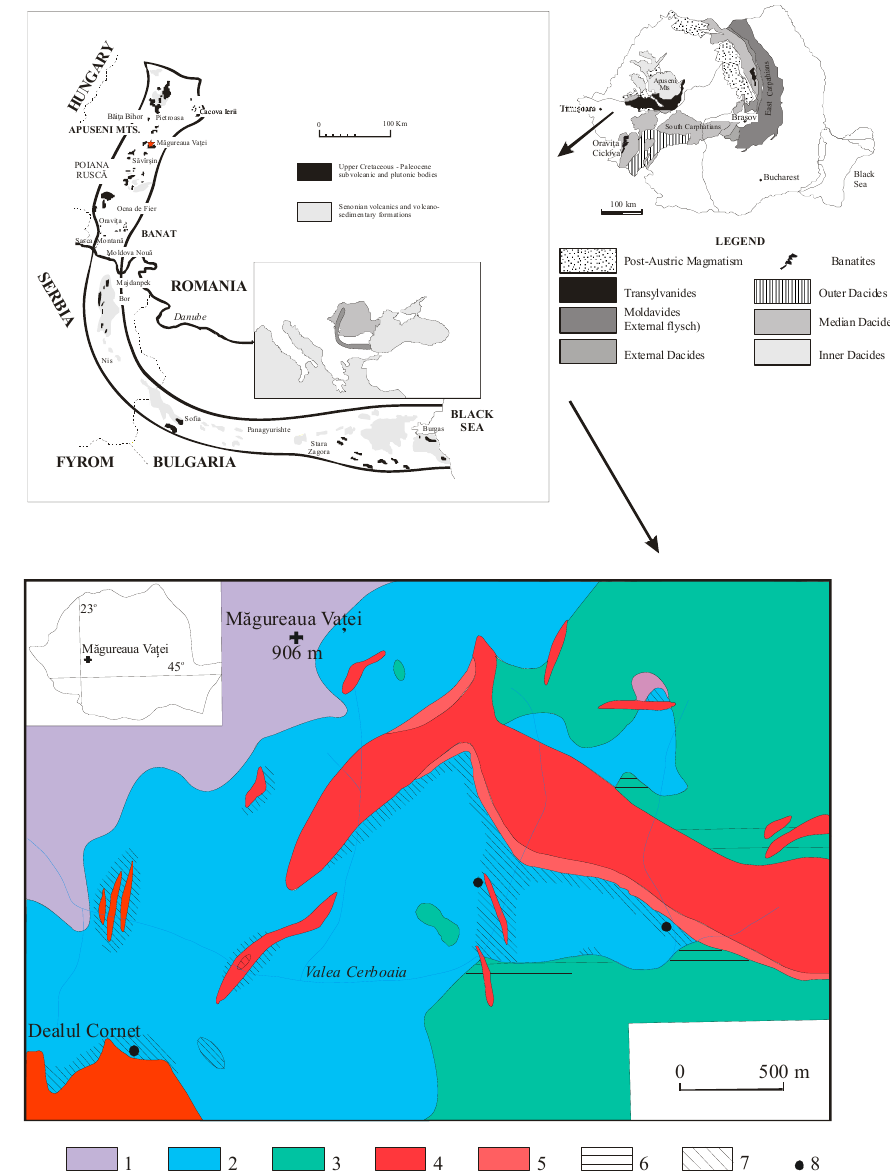
Figure 1. Geological sketch of M ă gureaua Va ţ ei zone (redrawn and modified from [5]) in the regional context: the Banatitic Magmatic and Metallogenetic Belt (top, left: redrawn from [18]) and the structural context of Romania (top, right: redrawn and simplified from) [19]. Symbols in the legend represent: 1—Mesozoic ophiolites; 2—Tithonic–Neocomian limestones (marbles); 3—Senonian clays, sandstones and conglomerates; 4—Quartz monzonites; 5—Monzonites; 6—Pyroxene